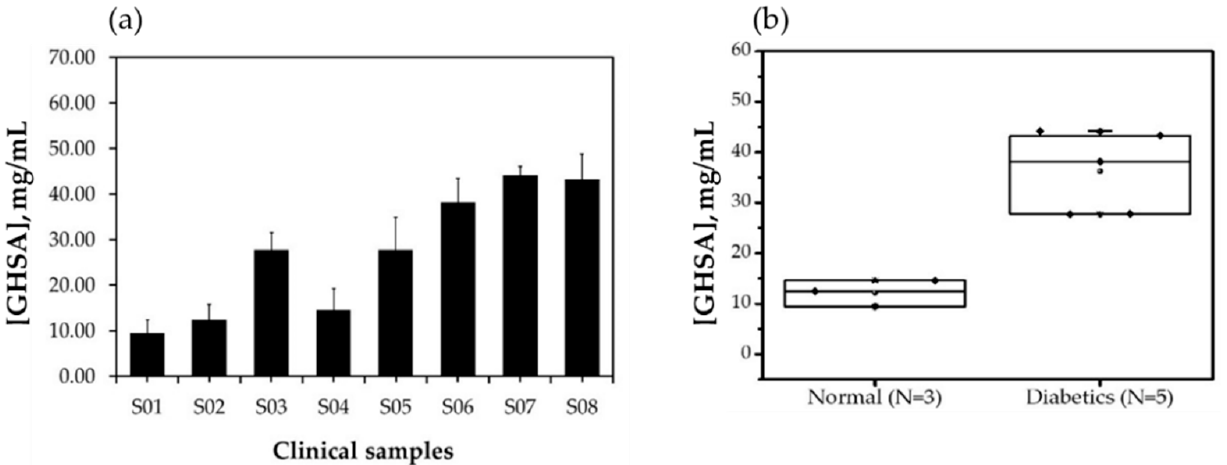
Figure 8. GHSA concentrations in eight human serum samples analyzed using the developed electrochemical aptasensor. Data are shown as a bar plot ( a ) and box plot ( b ). S01, S02, and S04 indicate serum samples from healthy individuals, and S03, S05, S06, S07, and S08 indicate serum samples from patients with diabetes.